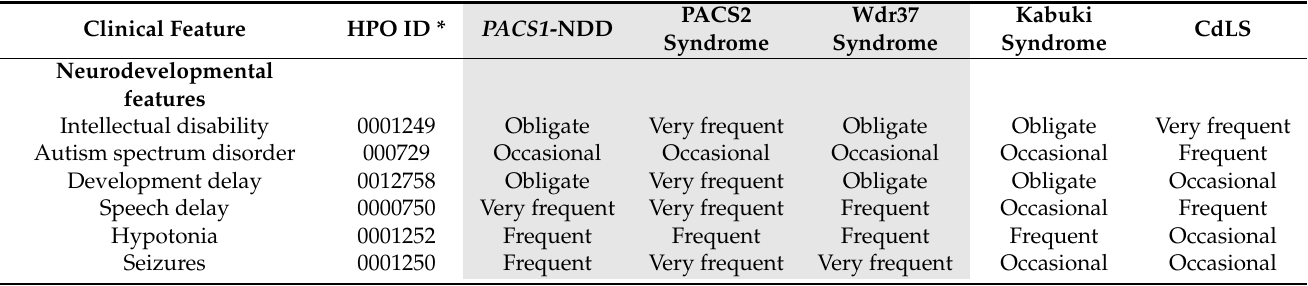
Table 1. Clinical characteristics of the PACS1 -NDD, PACS2, Wdr37, Kabuki and Cornelia de Lange